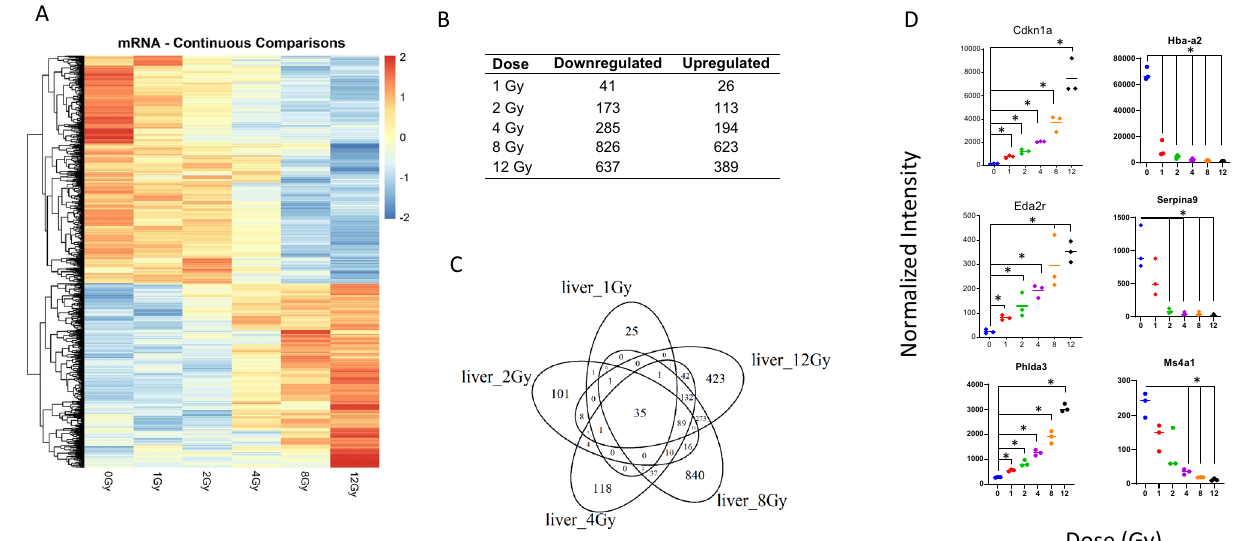
Figure 1. Radiation-induced gene expression profiles in mouse liver tissue. Whole genome microarray analysis was performed on all samples. A linear model was fit to each probe to evaluate differential expression of irradiated samples compared to controls. Criteria of (log 2 fold change ((log2FC) > 1 and Benajmini-Hochberg adjusted (B-H) p value < 0.05) relative to controls were used to determine significance and differential expression. ( A ) Heatmap displays expression patterns, represented by z-score, of all differentially expressed mRNAs across all doses and controls. ( B ) Venn diagram shows dose distribution and overlap of differentially expressed mRNAs across all doses. ( C ) The number of down-regulated versus up-regulated mRNAs at each dose are shown in the table. ( D ) Examples of significant linearly up- and down-regulated mRNAs are shown to display the dose response to radiation in liver tissue samples. Asterisk (*) indicates statistical significance.